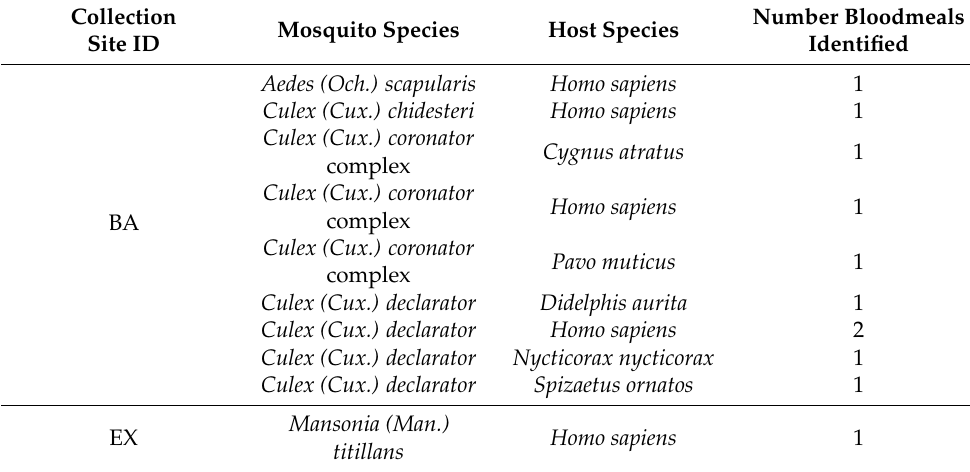
Table A2. Blood meals identified according to the collection site, mosquito, and host